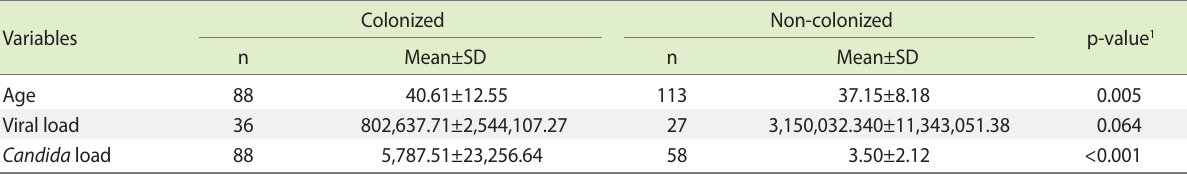
Table 3. Characteristics of the study population Variables